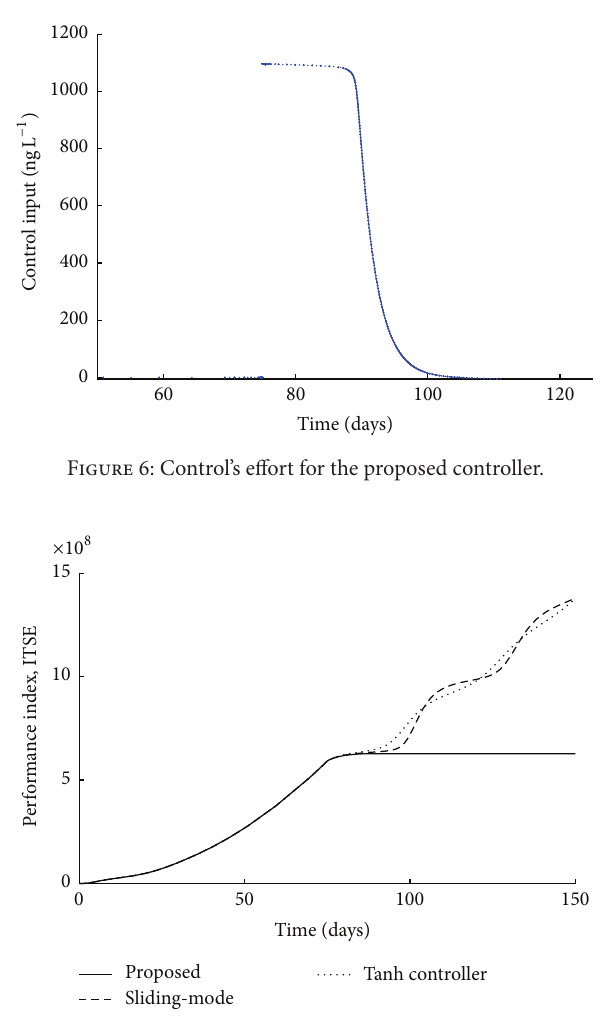
Figure 7: Performance index for the considered controllers.